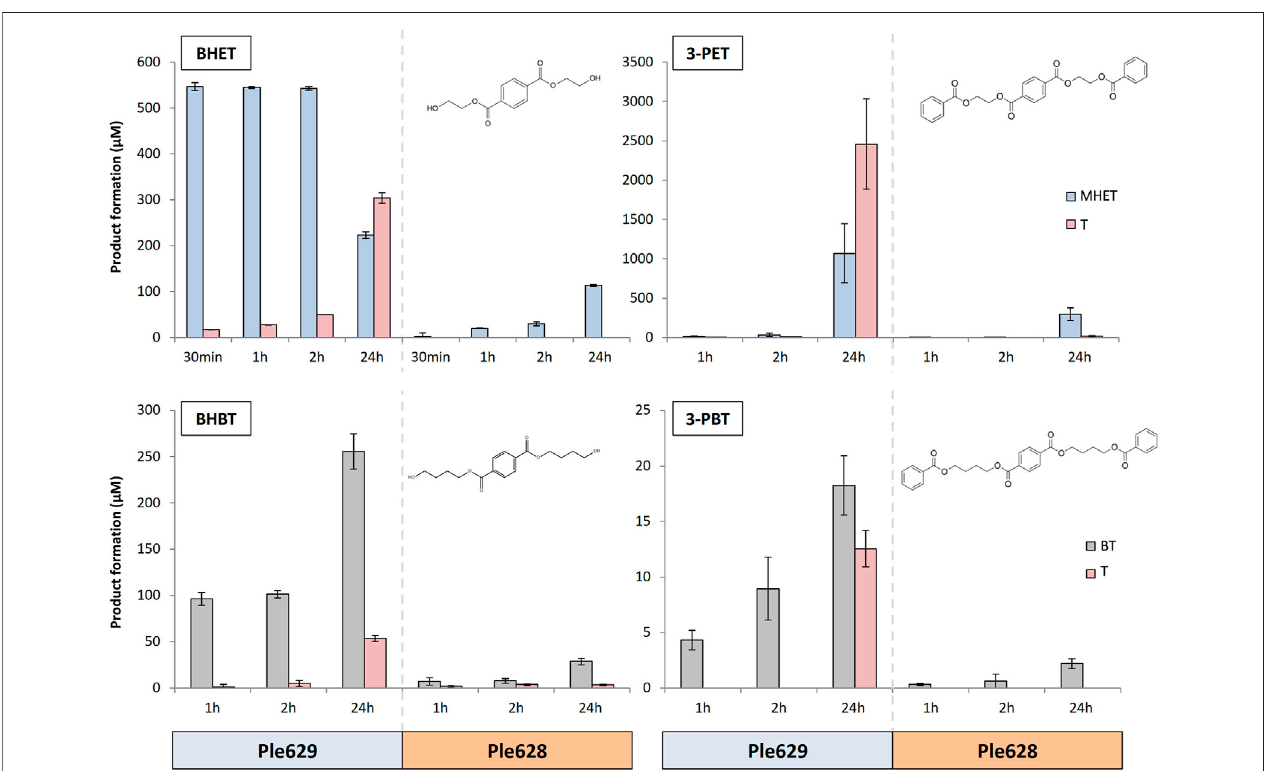
FIGURE 2| Degradation of small terephthalate-estersby Ples. Formation of T (dark pink) and MHET (light blue) or BT (light gray) (in µM) after degradation of BHET, BHBT,3-PET,and3-PBTbyPle628andPle629.ThedegradationofBHETand3-PETleadstotheformationofMHETandTandthedegradationofBHBTand3-PBTto the formation of BT and T. The molecular structure of each substrate is shown at the uppermost right corner of each bar plot. The sampling points are shown at 30 min, 1 h, 2h, and 24 h. The error bars indicate the standard deviation ( n = 3).